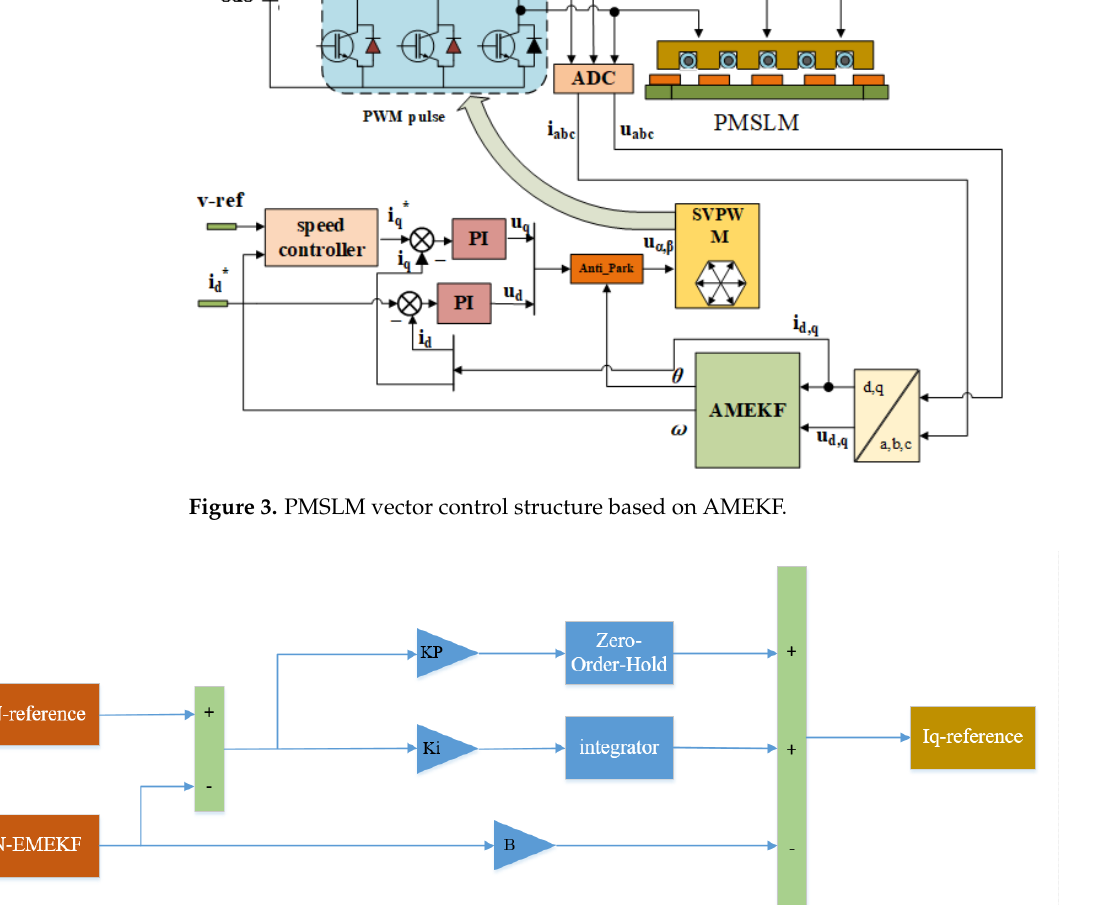
Figure 4. PI speed loop speed control structure.